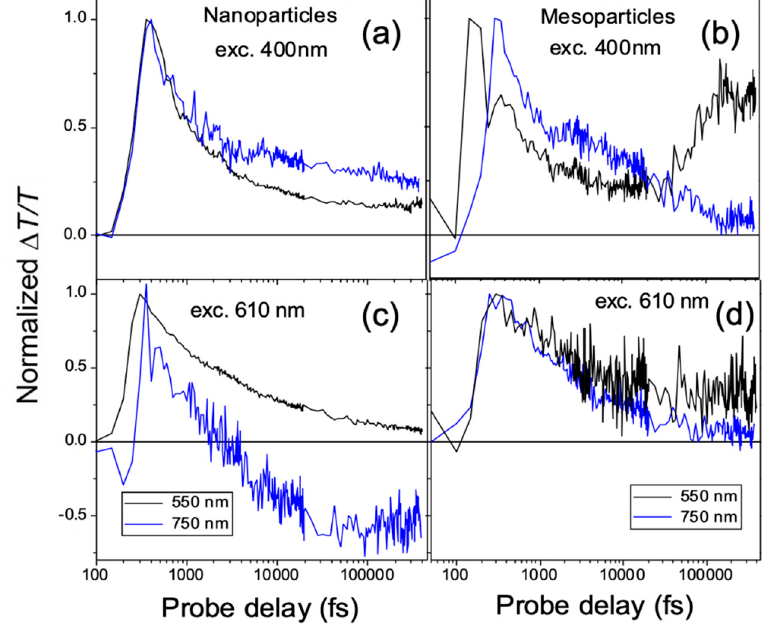
Figure 4. Time decays at different wavelengths for nanoparticle ( a , c ), and for mesoparticle ( b , d ), spin coated films at two different pump excitation wavelengths of 400 nm ( a , b ), and 610 nm ( c , d ) are displayed. The ordinates and abscissae for all axes are normalized ∆ T / T and probe delay spectively.